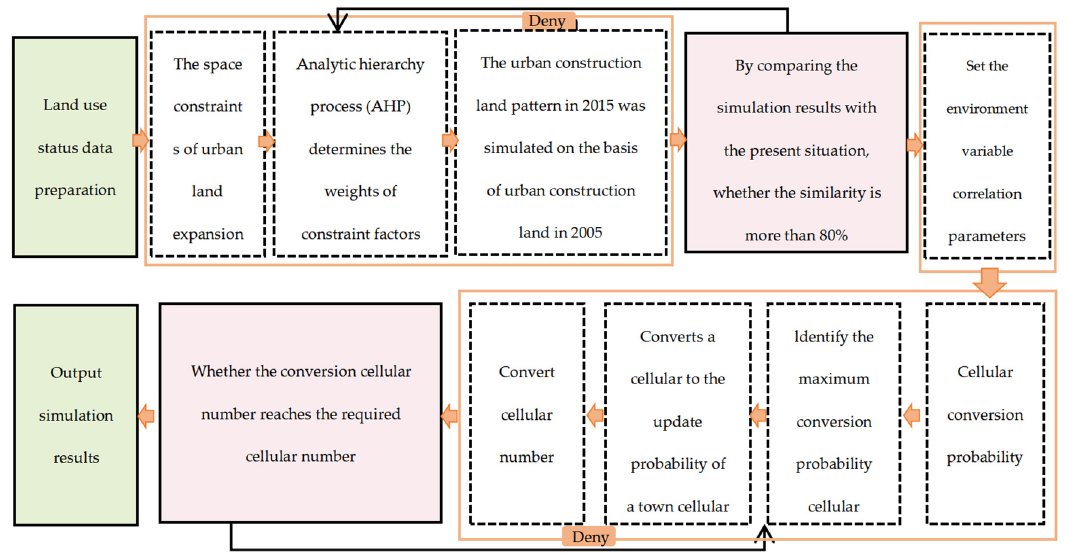
Figure 2. Flow of cellular automata simulation of urban expansion (derived from “Exploring the effects of partitioned transition rules upon urban growth simulation in a megacity region: a comparative study of cellular automata-based models in the Greater Wuhan Area”).